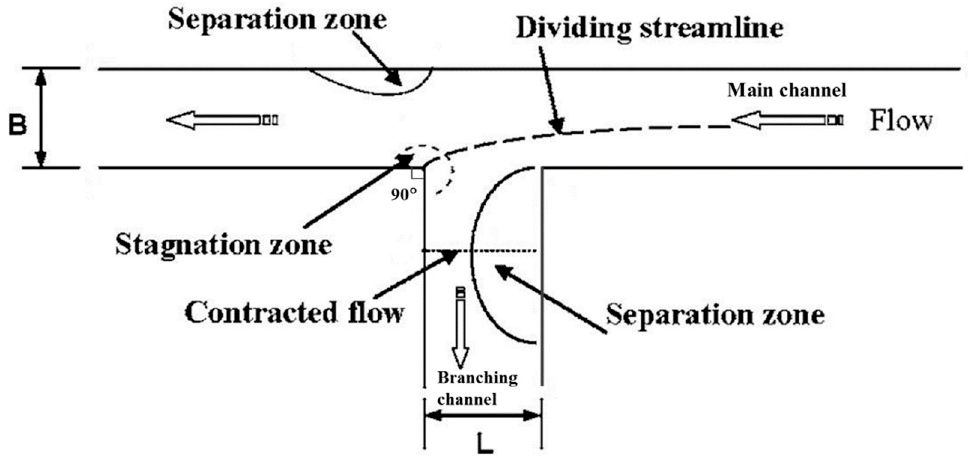
Figure 1. Characteristics of flow dynamics at a branching channel (Ramamurthy et al. [8]).